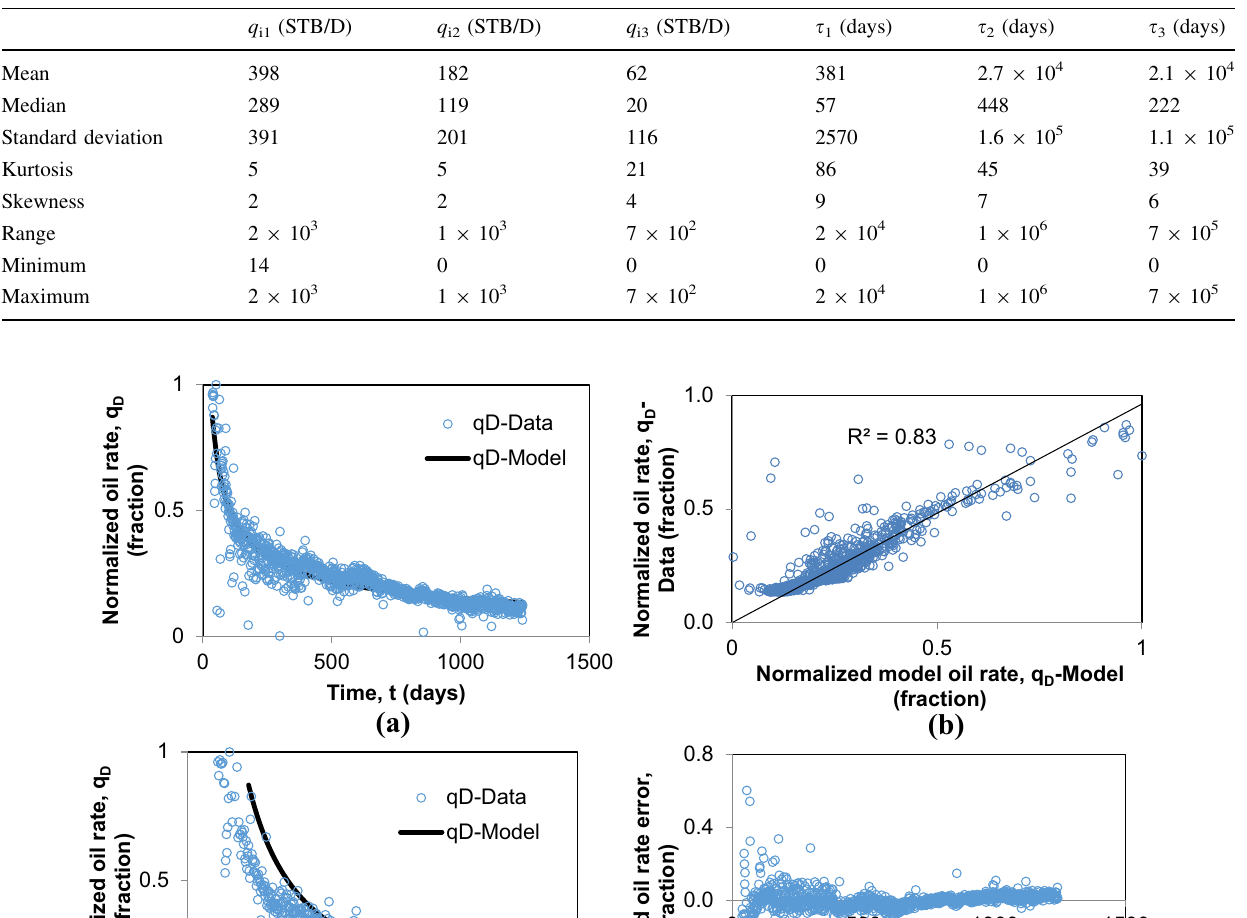
Table 2 Statistical summary of model fitting parameters for the parallel flow model